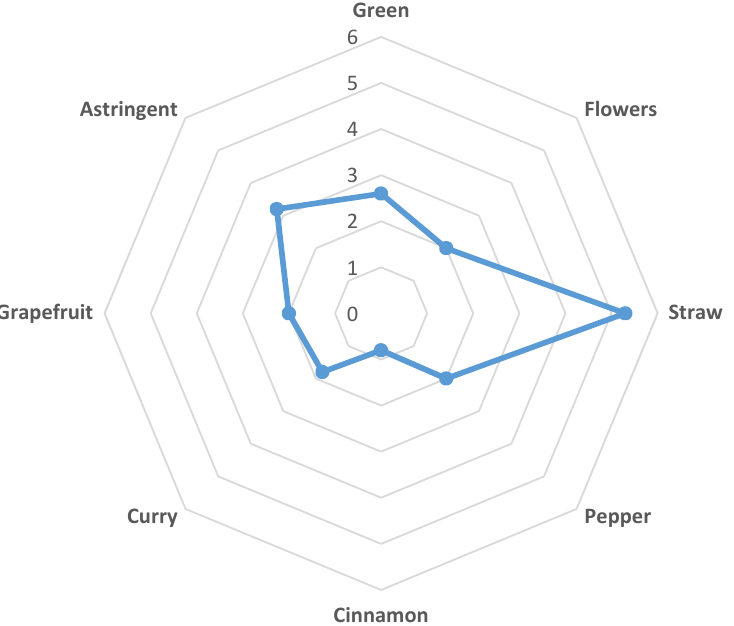
Figure 2. Sensory profile of HII infusion with possible aroma attributes is displayed as a spider web chart.